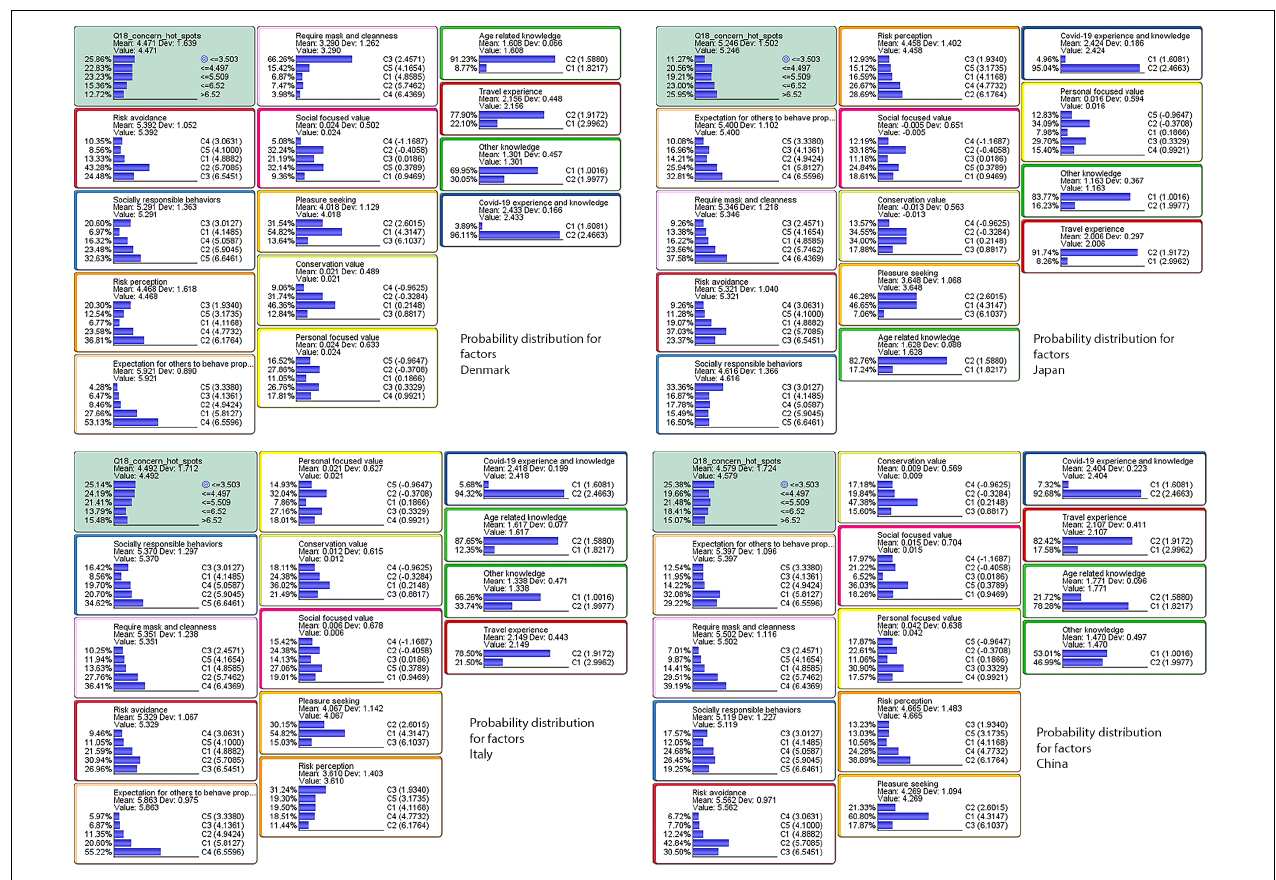
FIGURE 7 | Step 5: Country-specific probability distributions of the target variable and the 13 latent factor